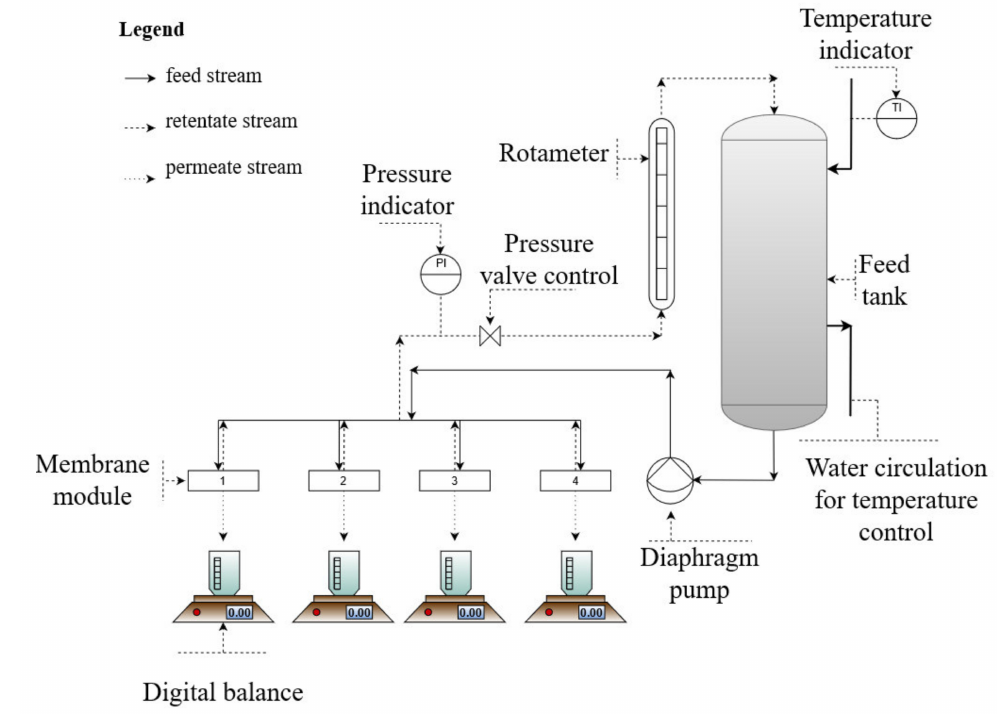
Figure 3. A schematic of the configuration of the cross-flow filtration system. To measure the removal of suspended solids, filtration experiments with CaCO 3 (1000 ppm) solution were conducted. The turbidity of the samples was measured with the Hach Model DR/2010 Spectrophotometer by means of the preinstalled programme #750. The removal efficiency was calculated using Equation